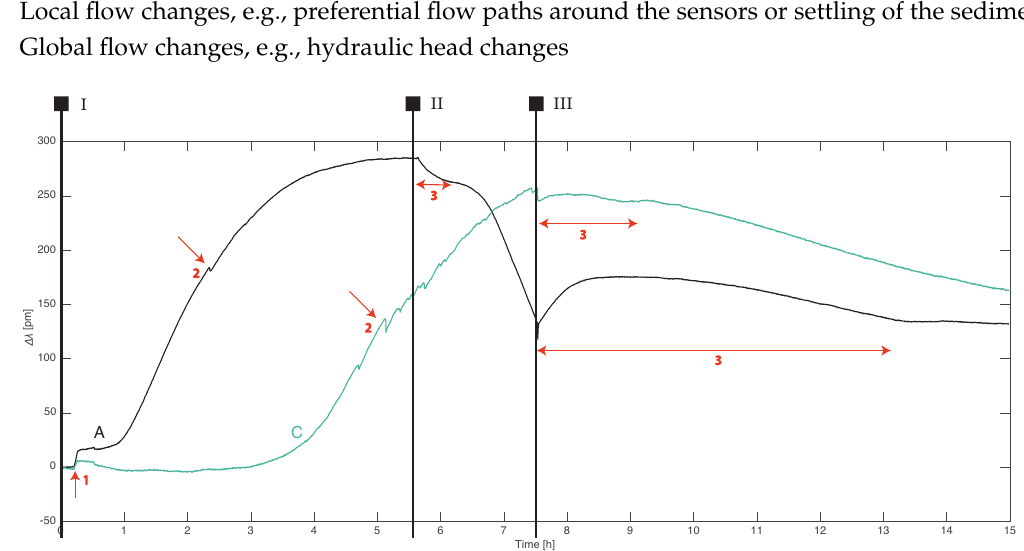
Figure 8. The wavelength shifts of the FBG sensors in rows A and C: The red arrows indicate strain events resulting from (1) setup adjustments, (2) local flow, or (3) global flow changes. The Roman numerals demarcate the different experimental stages consistent with Figure